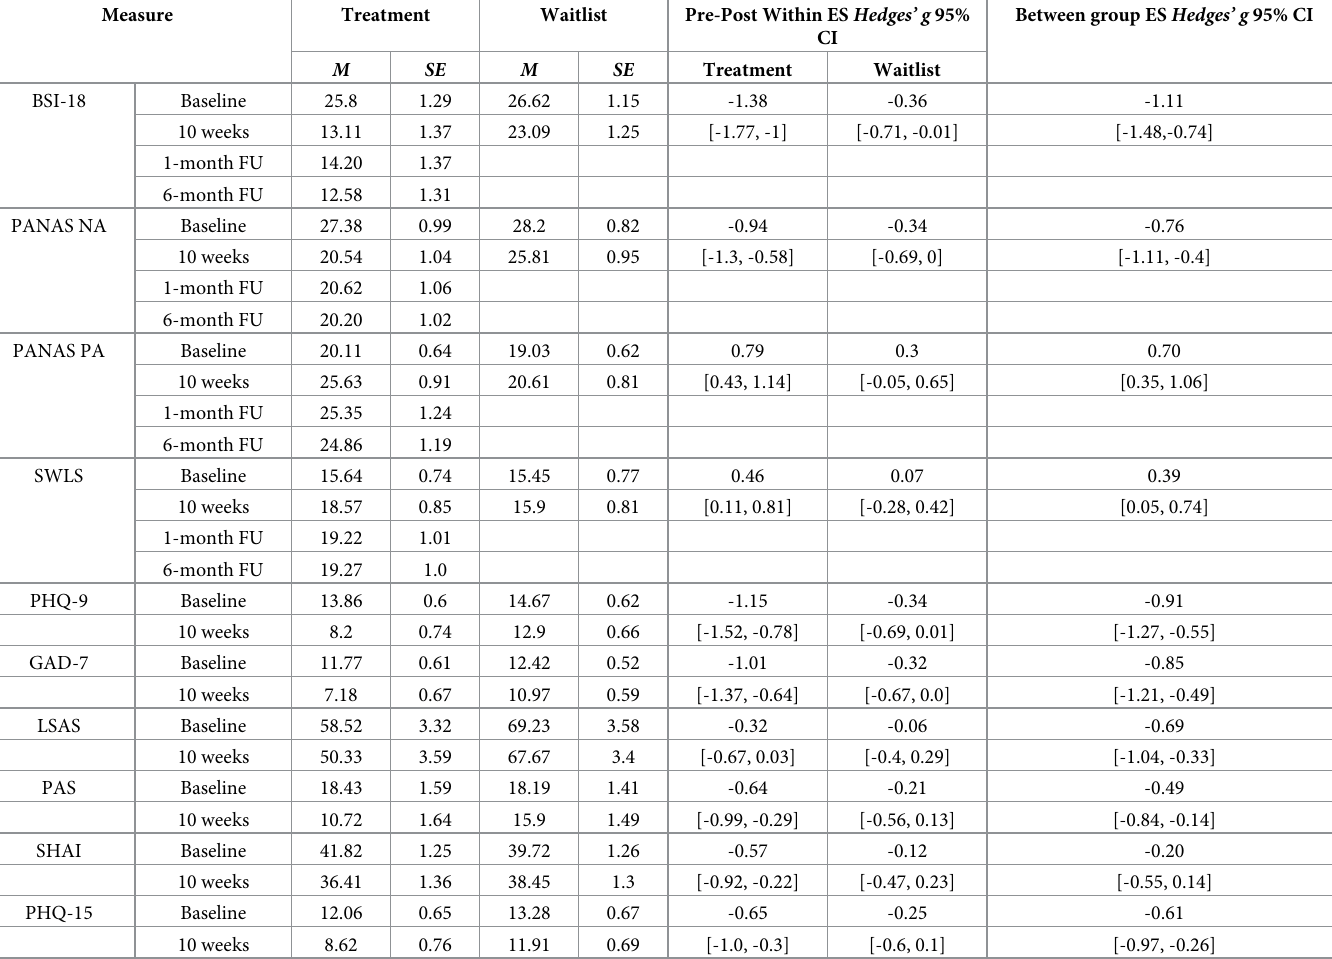
Table 4. Predicted means and standard errors for primary and secondary outcome measures and within- and between-group effect sizes.